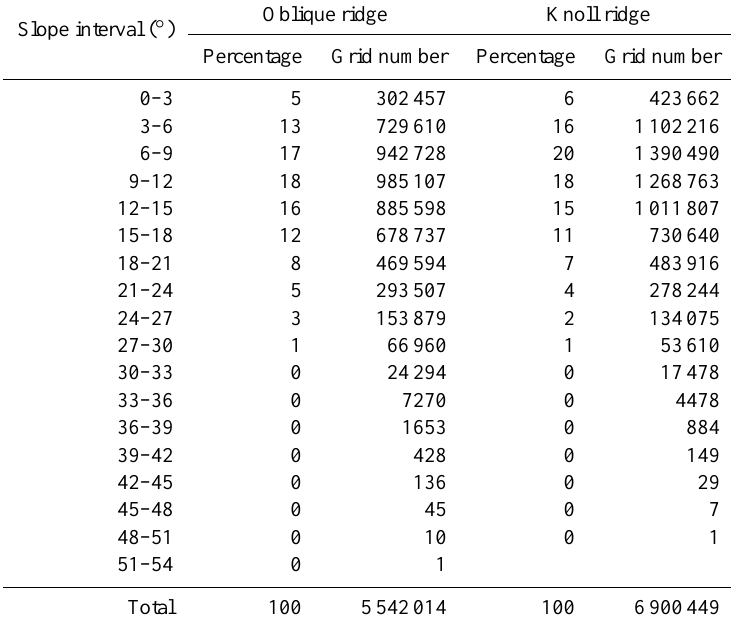
Table 4. Distribution status of the slope intervals for the subtypes of the loess ridge. Oblique ridge Knoll Slope interval ( ◦ )